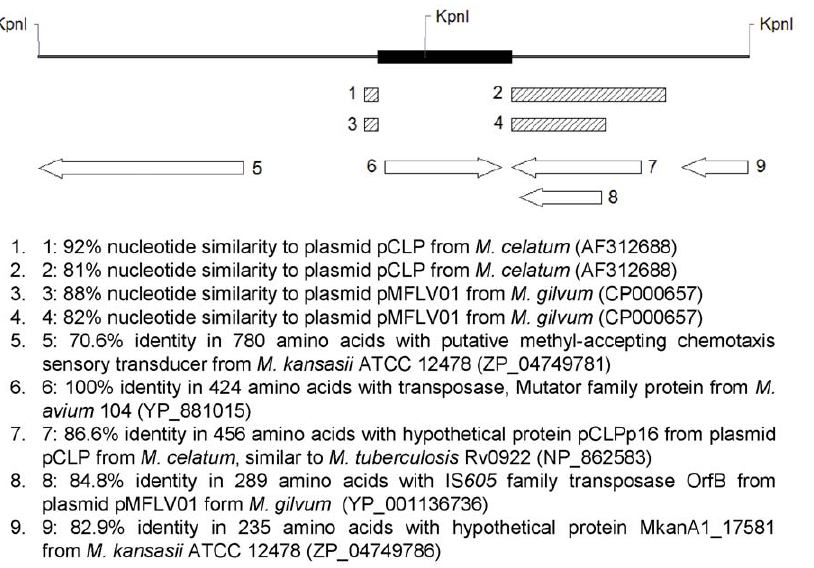
Table 1. Conjugation experiments using M. avium 88.3 as the donor strain.